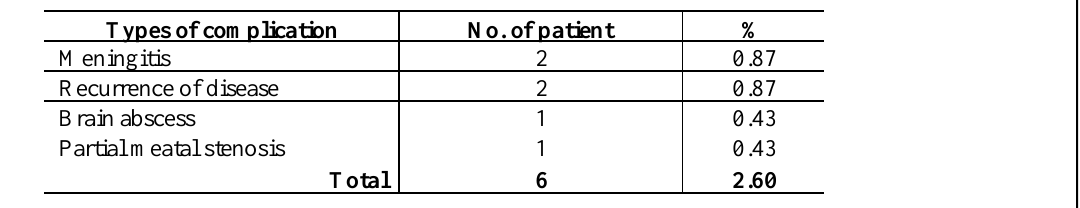
Table IV : Types of late complications (n=230)